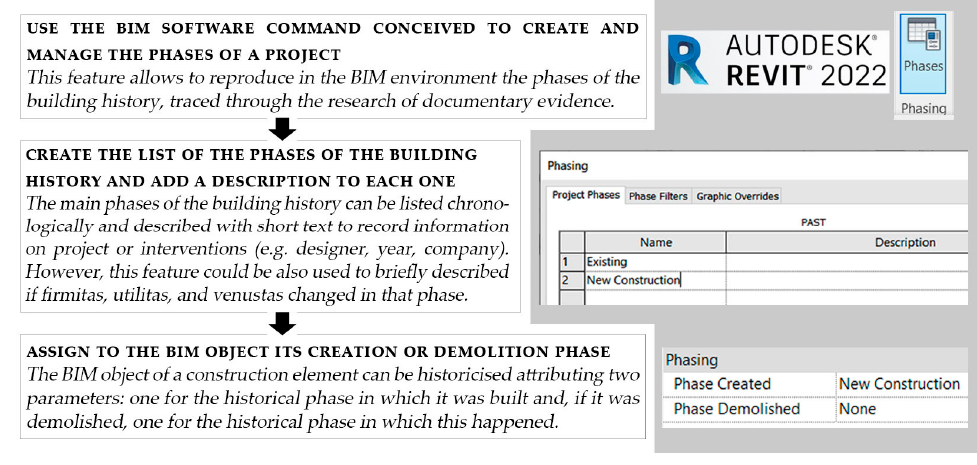
Figure 7. The method to historicise a BIM model.